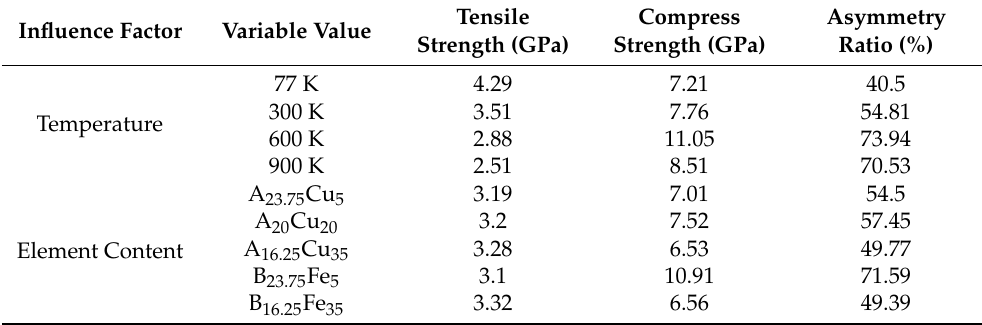
Table 3. Tension-compression asymmetry of HEAs at different temperatures and component propor- tions, where A x is Fe x Ni x Co x Cr x ( x = 23.75, 20, 16.25) and B y is Ni y Co y Cr y Cu y ( y = 23.75, 16.25). Variable